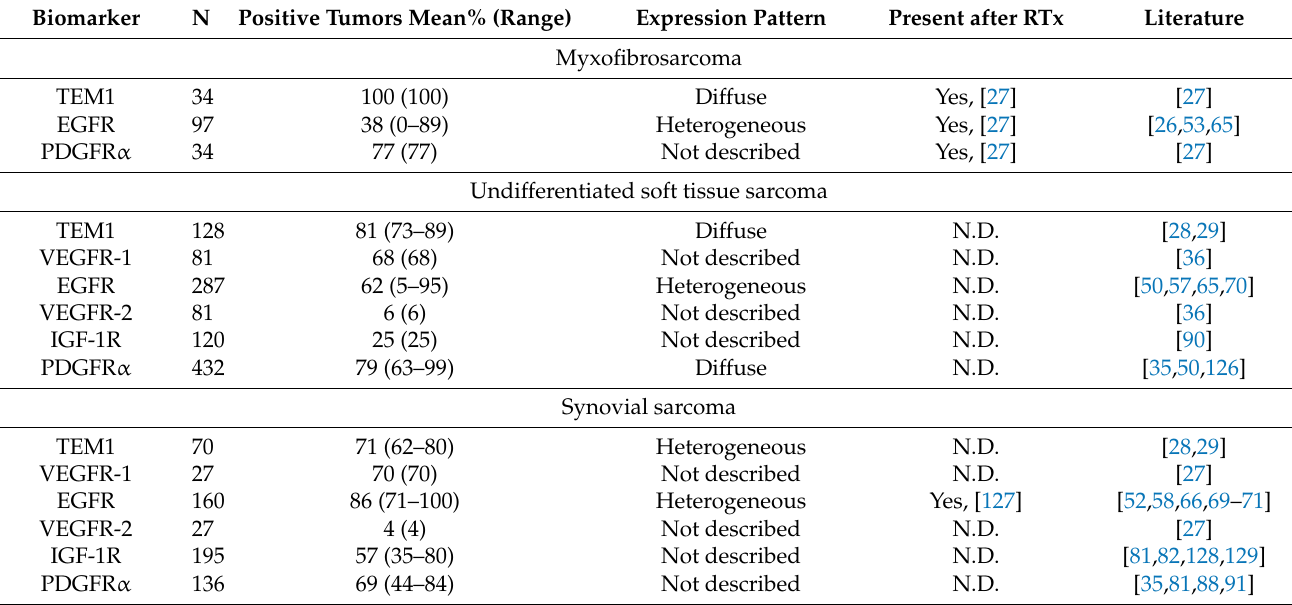
Table 3. Summarized data regarding biomarkers in myxofibrosarcoma, undifferentiated soft tissue sarcoma, and syn- ovial